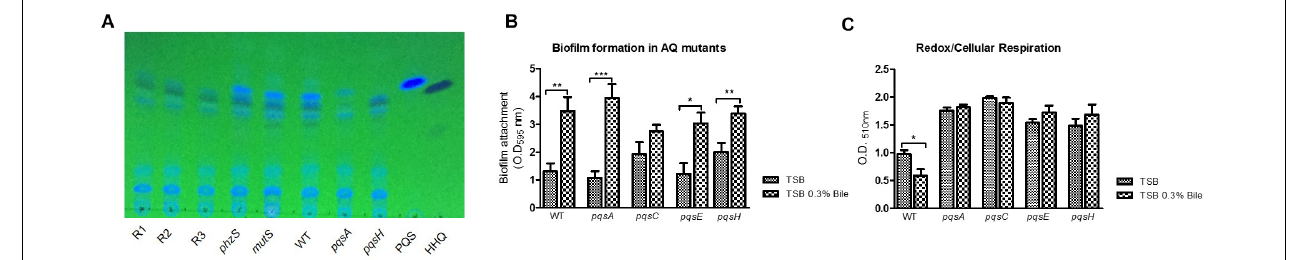
FIGURE 6 | (A) TLC analysis indicates loss of PQS production in pigmented mutants, consistent with the possible loss of lasR identified in the SNP comparisons. A phzS mutant retains PQS production, indicating loss of PQS occurs independent of pigment production. (B) Mutation of the biosynthetic genes for PQS did not significantly alter bile induced hyper-biofilm formation. (C) Mutation of the biosynthetic genes for PQS resulted in a loss of bile induced redox repression. Data is the mean of at least three independent biological replicates. Statistical analysis was performed by Student’s t -test ( ∗ p ≤ 0.05; ∗∗ p ≤ 0.01; ∗∗∗ p ≤